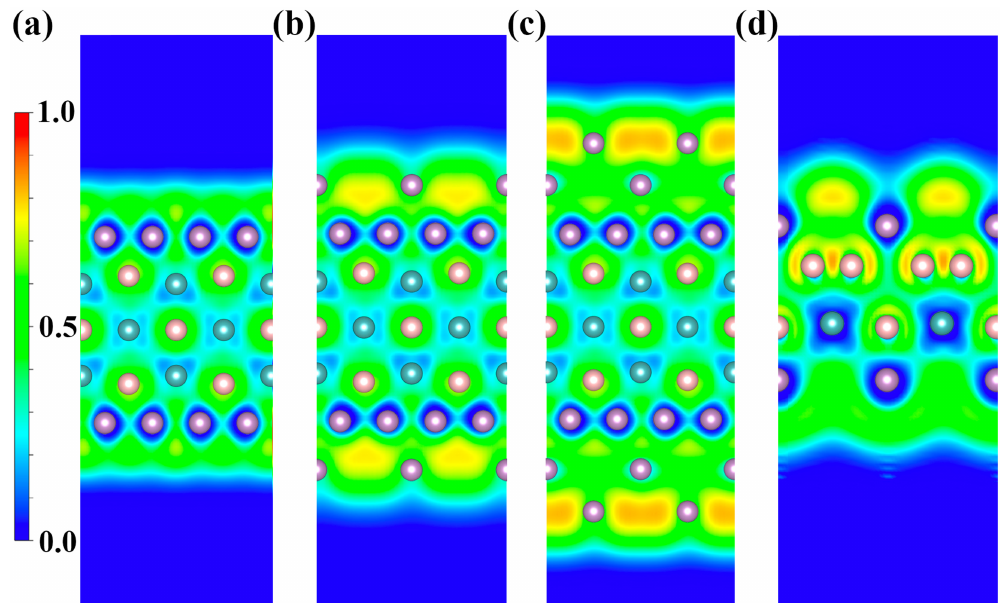
Fig. 6 Li adsorption. Electron localization functions of the MoB monolayer with a one, b two, and c three layers of adsorbed Li atoms [(110) plane], and d of the MoB 3 monolayer with one layer of adsorbed Li atoms [(010) plane].